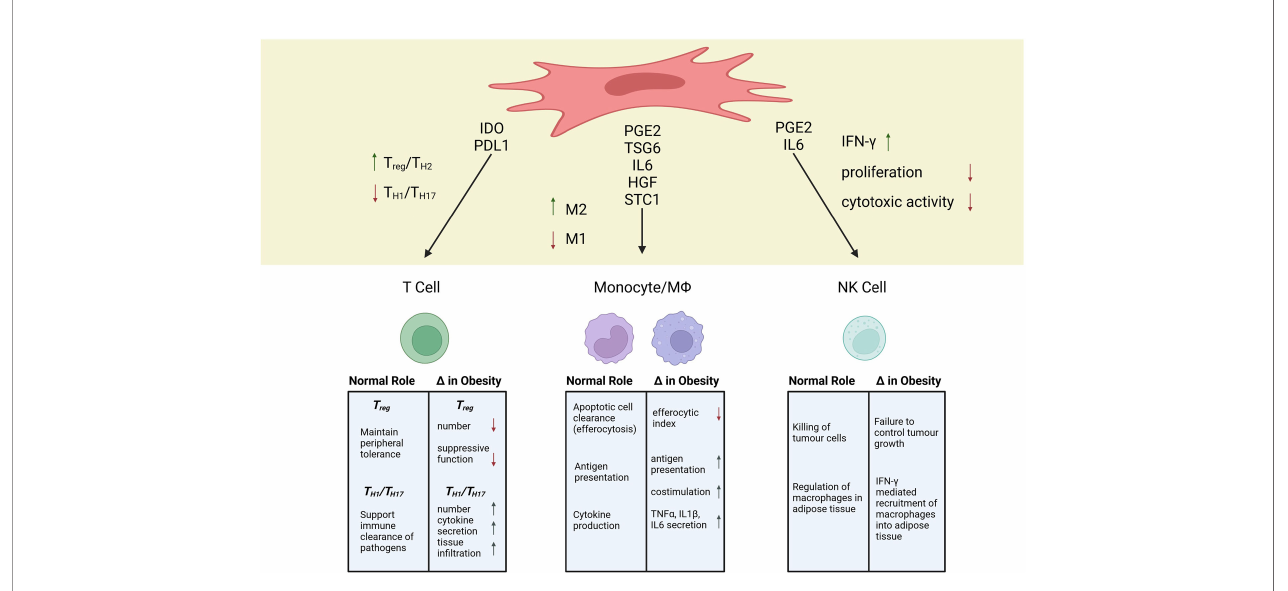
FIGURE 1 | Mechanisms of MSC Immunosuppression and Alterations to Immune Populations in Obesity. Created with